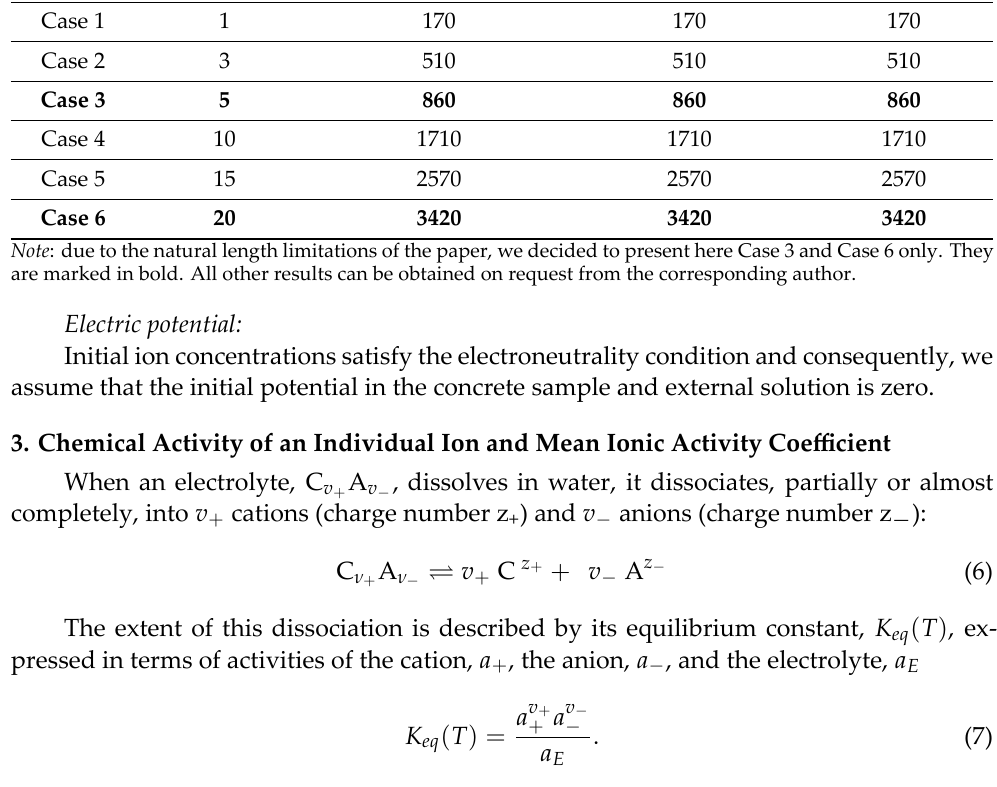
Table 2. Iinitial concentrations of ions in the external solution c 0 (1, 3, 5, 10, 15, and 20% NaCl water solution). I denotes the molar ionic strength of the solution. NaCl wt % Ion 1: Na + (mol m − 3